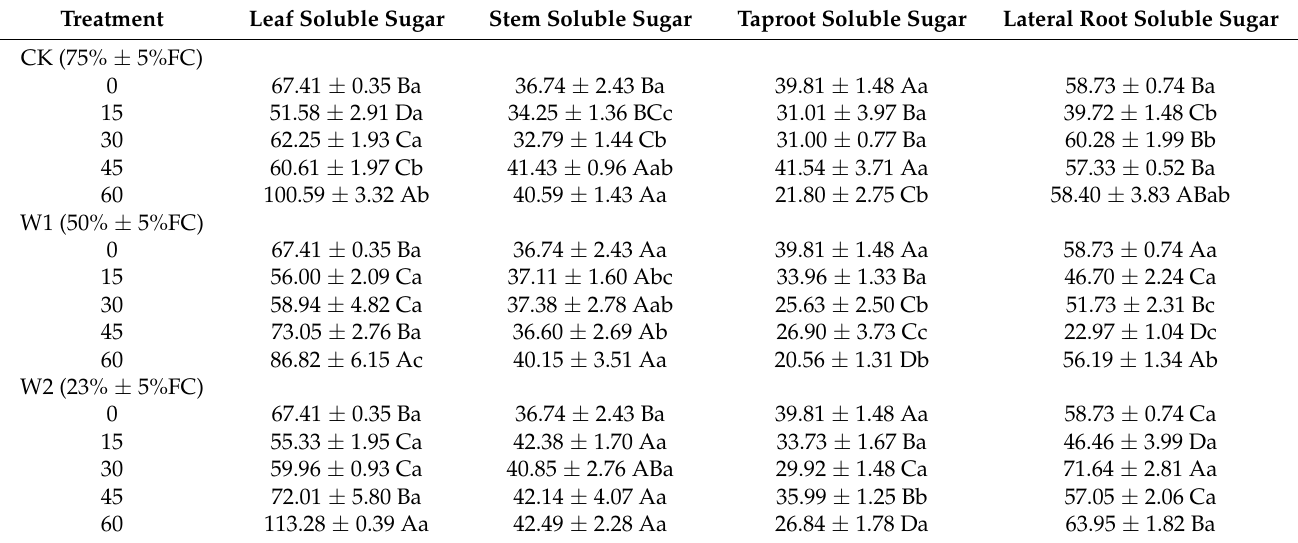
Table 1. The soluble sugar content of Mongolian oak seedlings in leaves, stems, taproots, and lateral roots under different drought intensities and durations.